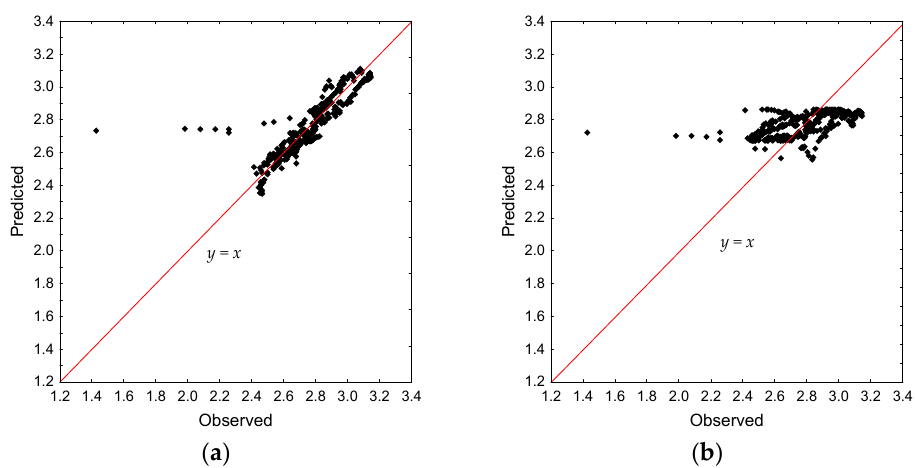
Figure 3. Relationship between observed and predicted GWLs (m) with SVR time series in the N-8 well in the test subset for the best ( a ) and the worst ( b ) combination of predictors.